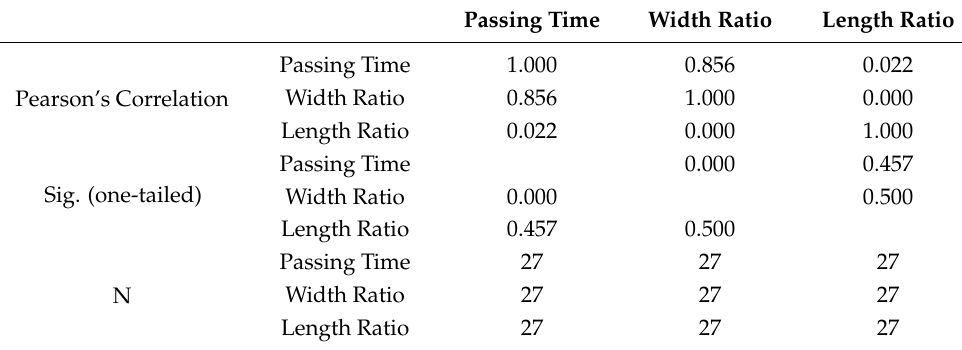
Table 3. Pearson’s correlation